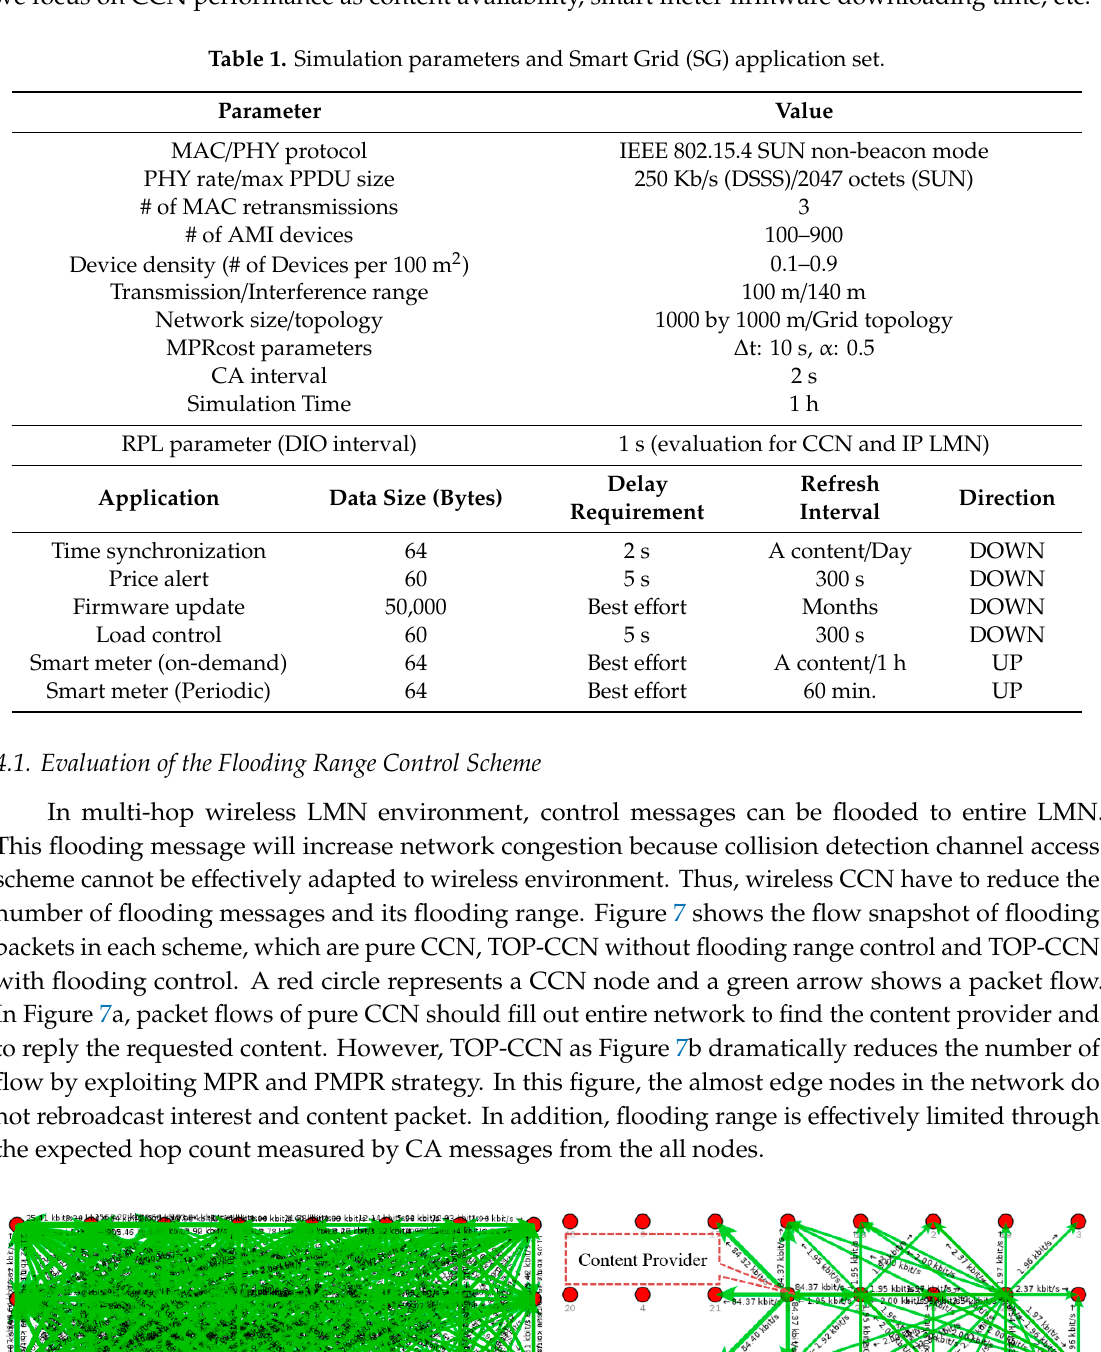
Table 1. Simulation parameters and Smart Grid (SG) application set.